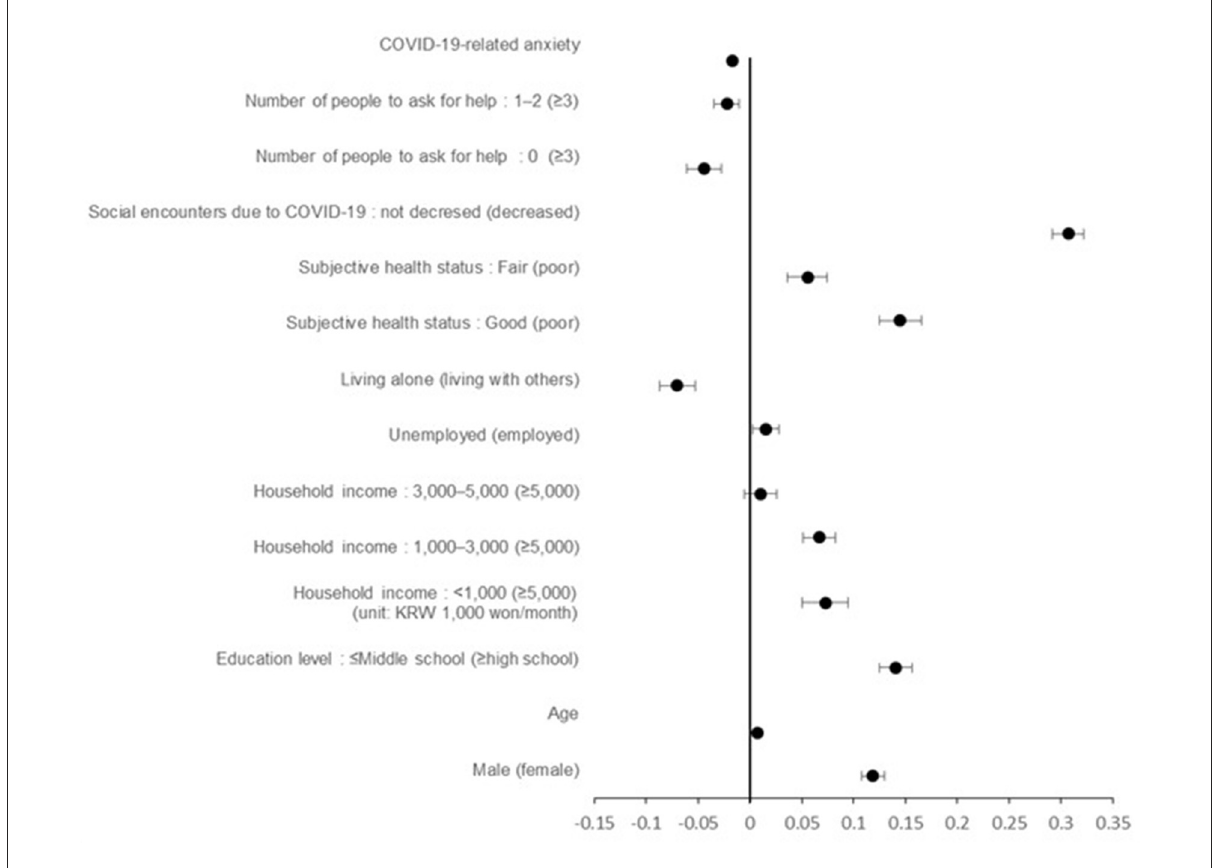
FIGURE1 Forest plot of healthy behavioral change index related